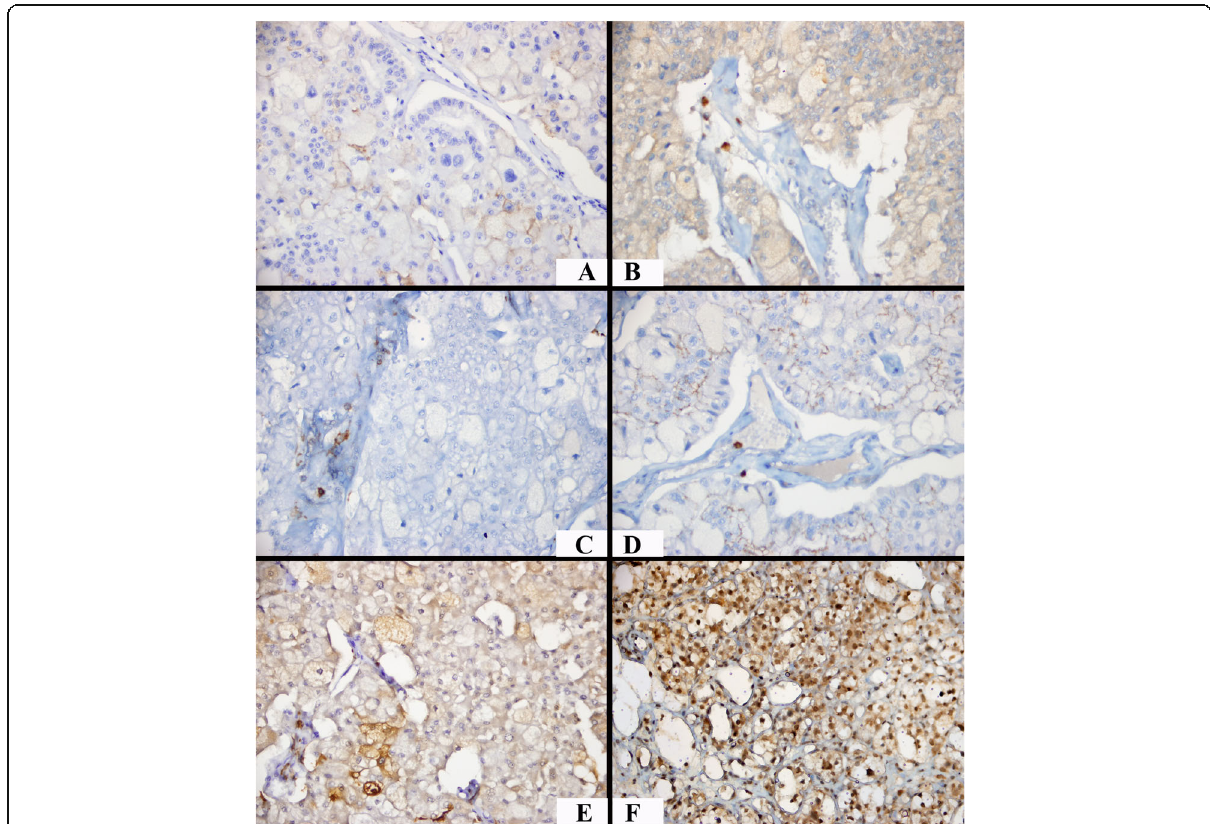
Fig. 2 A case exhibiting PD-L1-expression in a few cells with a mild lymphocyte density in the microenvironment, low HIF-2 α expression, and high HIF-1 α expression (× 400). a Scarce incomplete membranous PD-L1 staining. b PD-1-positive mild lymphocytic infiltration, c CD4-positive mild lymphocytic infiltration. d CD8-positive mild lymphocytic infiltration, e Low-score HIF-2 α expression. f High-score HIF-1 α